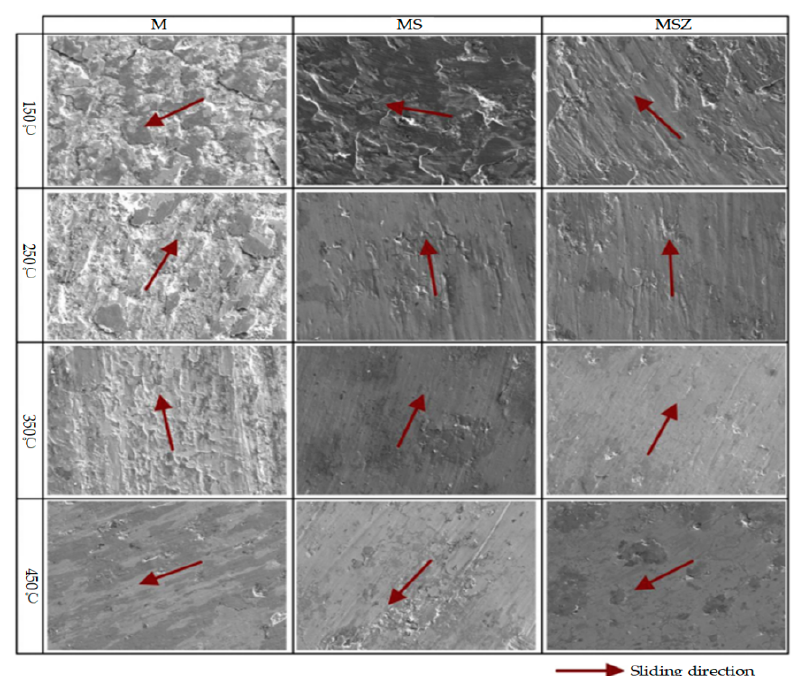
Figure 15. EPMA of frictional surface of M, MS, and MSZ under different temperatures (Reprinted with permission from Ref. [142]. Copyright 2020 Elsevier)